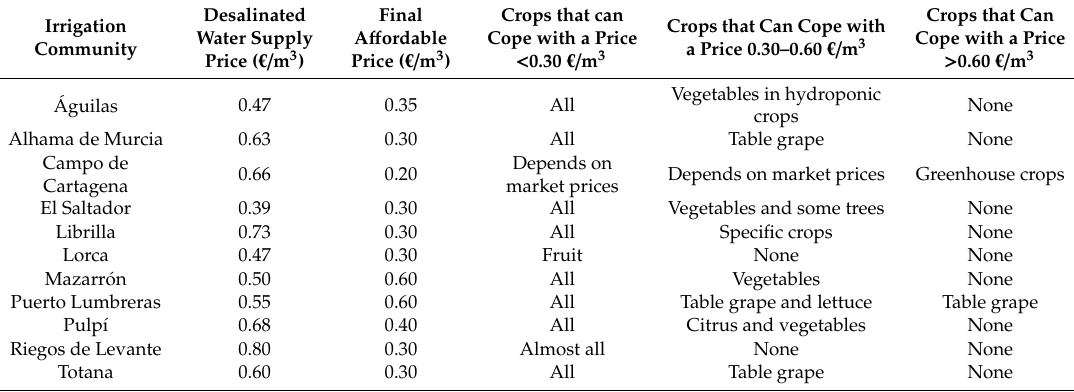
Table 3. Desalination water supply price, final a ff ordable price and types of profitable crops based on water